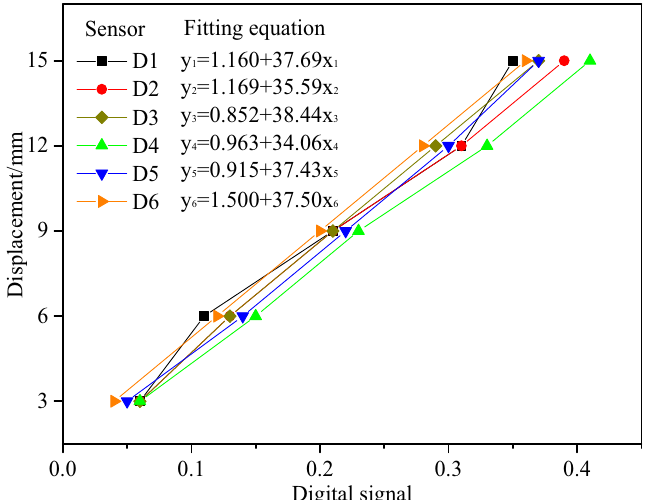
Figure 6. Data linear fitting and regression equation.